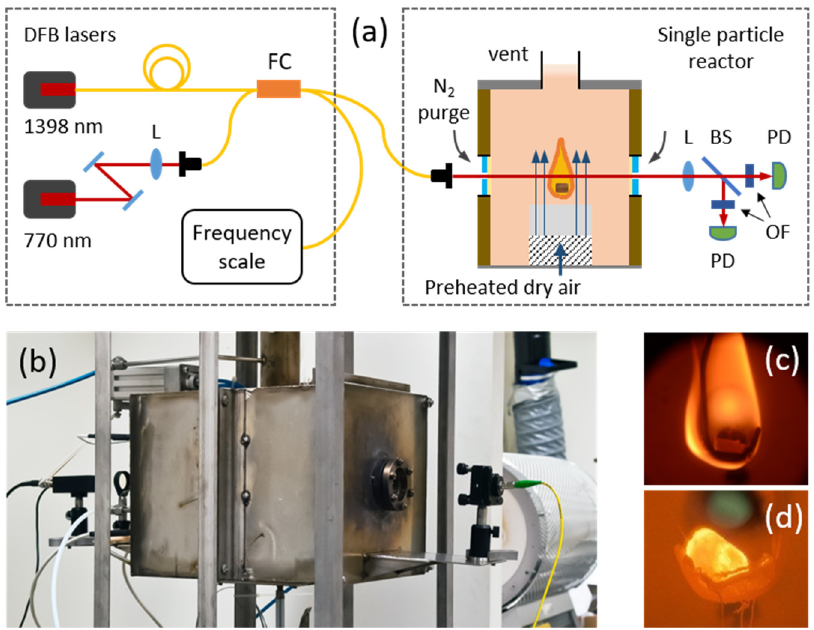
Figure 1. ( a ) Schematic drawing of the experimental setup including the two DFB lasers, the single particle reactor (SPR) and the optical detection system. FC—fibre combiner, BS—beam splitter, PD—photodetector, OF—optical filter. ( b ) Photograph of the SPR with TDLAS optics mounted. ( c ) Representative photograph of a biomass particle inside the SPR during devolatilization. ( d ) Representative photograph of a biomass particle inside the SPR during char conversion.